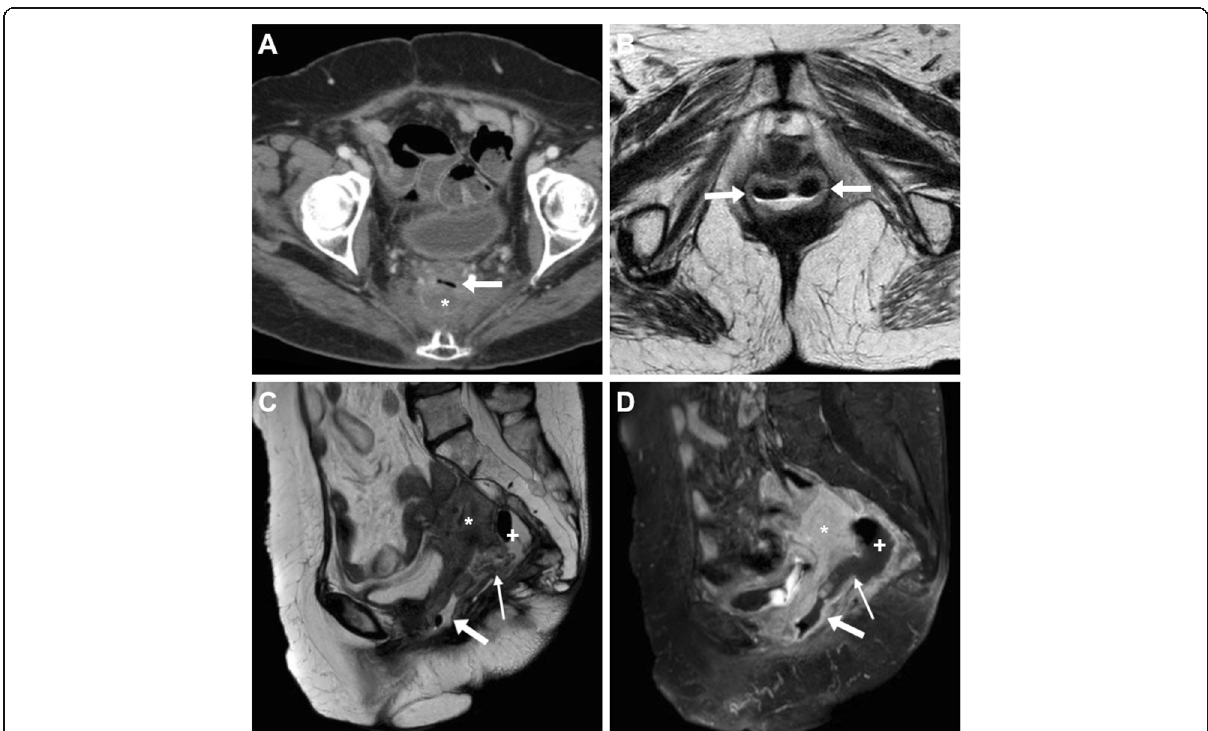
Fig. 7 Neoplastic recto-VF, CT and MRI findings of VF-related vaginitis. In a 72-year-old with previous hysterectomy and resected rectal carcinoma, CT ( a ) shows local recurrence (*) indissociable from the air-filled vagina (arrows). Despite impossible gynaecological exploration, T2-weighted images ( b , c ) and fat-suppressed (FS) post-gadolinium T1-weighted ( d ) MRI images show increased solid tumour mass (*), air- and fluid-filled vagina (arrows) with circumferential wall thickening, oedematous T2 signal intensity and positive enhancement. The fluid-filled communication